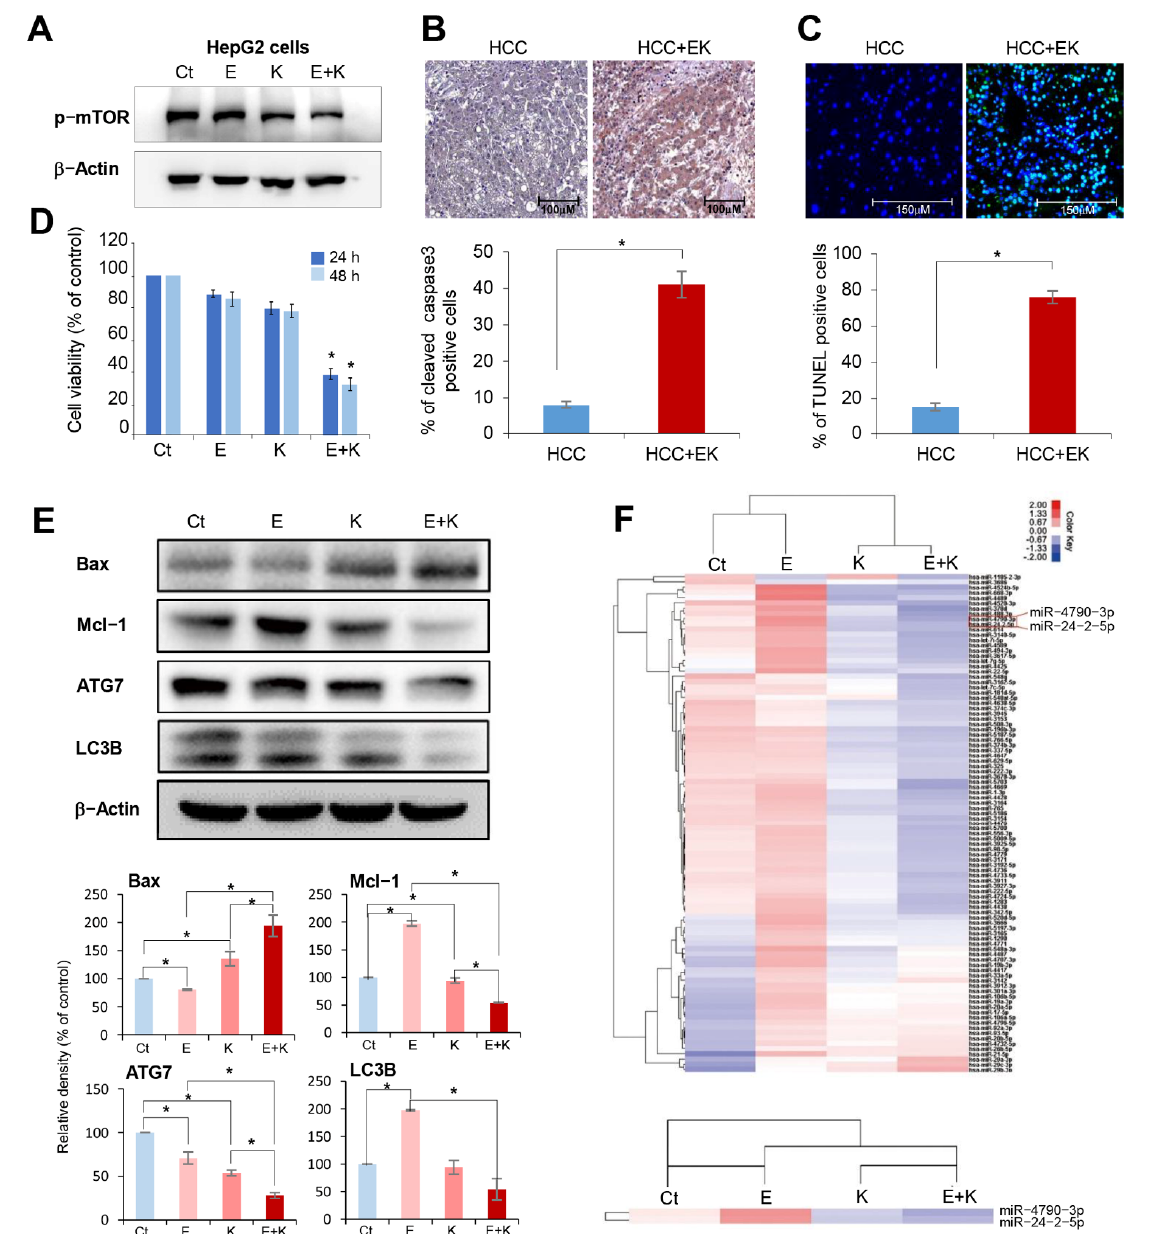
Figure 1. Comparison of expressions of miRNAs in mono- and combination therapies of everolimus and Ku0063794. ( A ) Western blot analysis showing the effects of each treatment on the expression of p-mTOR. ( B ) Cleaved caspase-3 immunohistochemistry with and without combination therapy in hepatocellular carcinoma (HCC) tissues. ( C ) TUNEL staining with and without combination therapy in HCC tissues. ( D ) Cell proliferation assay of HepG2 cells following mono- and combination therapies of 100nM everolimus and 1μM Ku0063794. Compared to the monotherapies of everolimus and Ku0063794, the combination therapy significantly reduced the viability of HepG2 cells. ( E ) Western blot analysis of HepG2 cells following mono- and combination therapies. Combination therapy induced a significant increase in the expression of Bax, a decrease in the expression of Mcl-1, and a decrease in the expression of autophagy markers. ( F ) The heat map of dysregulated miRNAs in HepG2 cells following mono- and combination therapies. Overall, everolimus monotherapy increased the expression of many miRNAs, Ku0063794 monotherapy reduced the expression of many miRNAs, and mixed therapies resulted in increased or decreased expressions of several miRNAs. Of all miRNAs, the alterations in the expression of miR-4790-3p and miR-24-2 were most prominent according to each treatment. Values are presented as means ± standard deviations of three independent experiments. Note: * p < 0.05. Abbreviations: Bax, Bcl-2-like protein 4; E, everolimus, K, Ku0063794, Mcl-1, myeloid cell leukemia